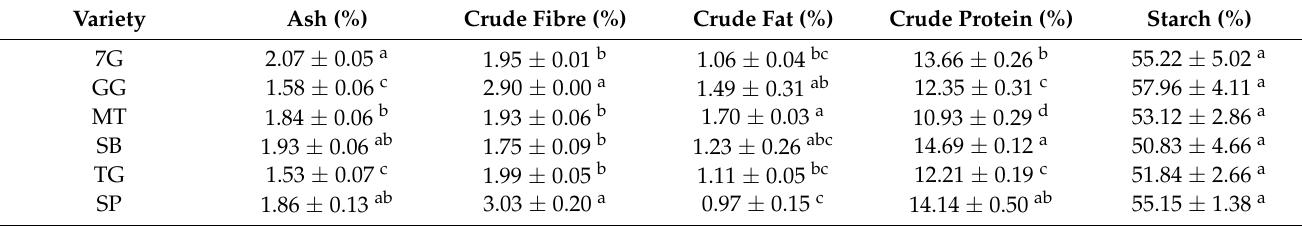
Table 2. Compositional analyses performed on wheat flours. The nutrient composition is expressed on a dry matter (DM) basis.